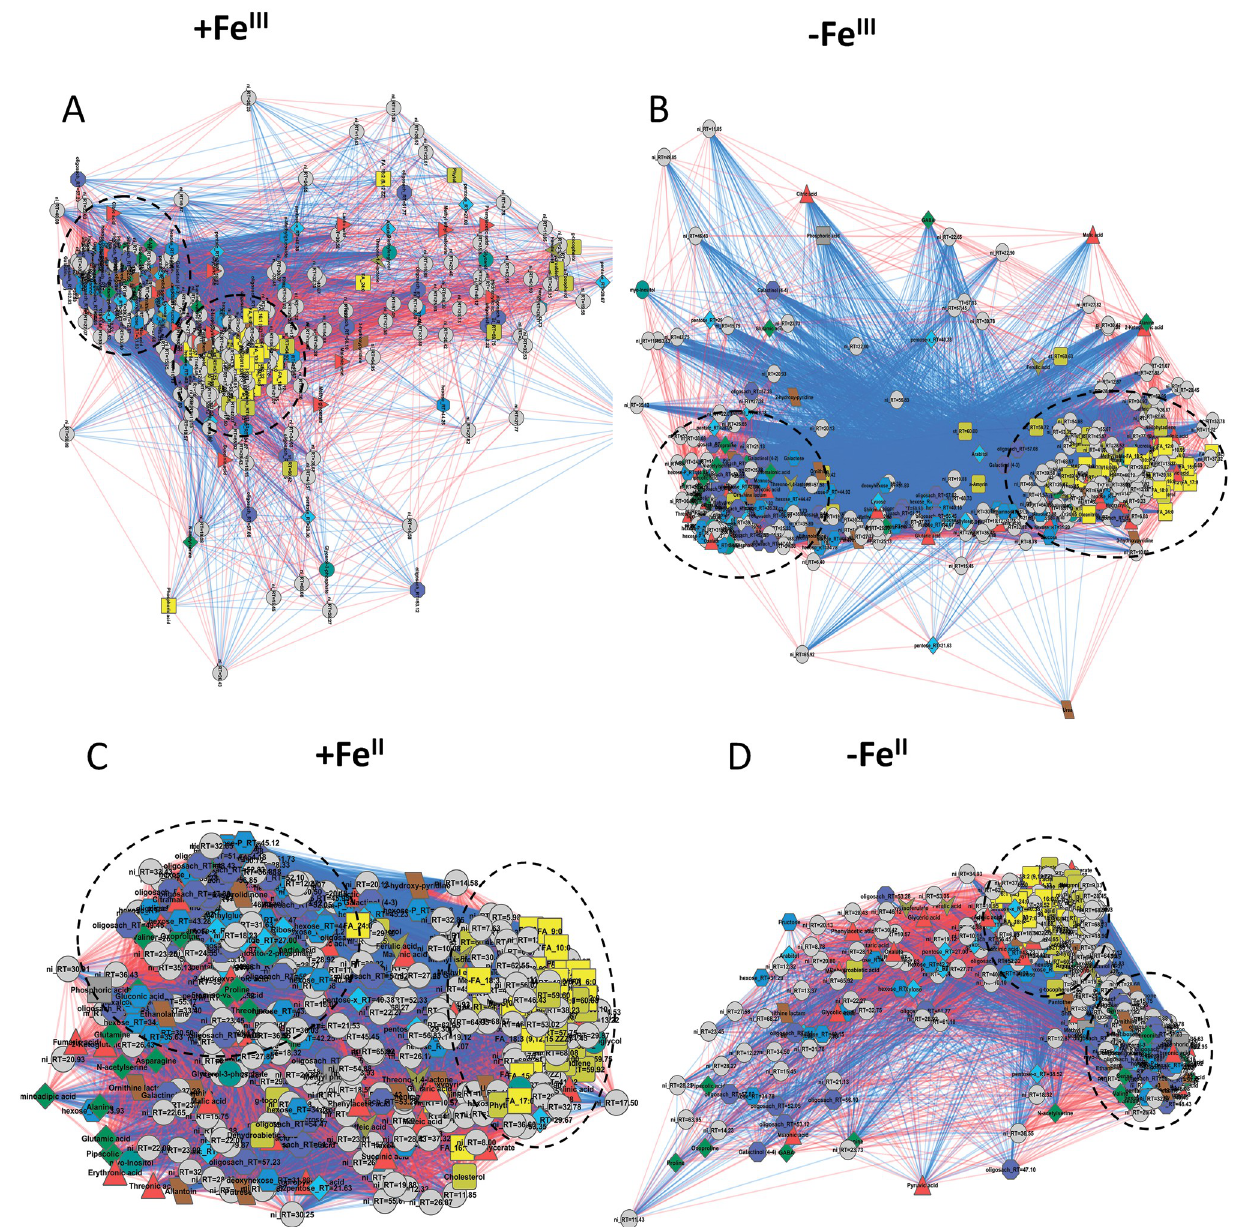
Fig 8. Mapping of leaf metabolites by correlation of the content levels in cucumber plants grown hydroponically in a nutrient solution, either with (+Fe II and +Fe III ) or in Fe-free ( − Fe II and − Fe III ) nutrient solution for 10 days. The nodes are metabolites; the shapes and colours reflect the chemical nature of the compound. Edges are strong correlations (r >